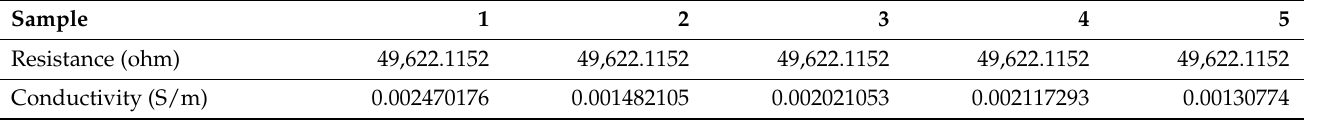
Table A9. Conductivity Data for Nylon 610 Nanocomposites with 3.5 wt% Graphite Nanosheets Treated at 175 ◦ C and − 1 bar.